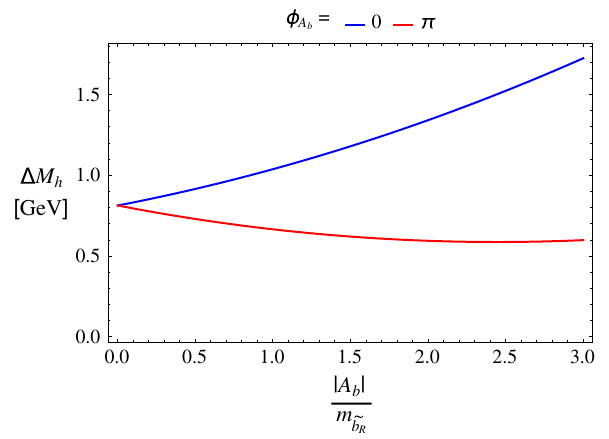
Fig. 6 Dependence of the lightest Higgs-mass shift (cid:7) M h on | A b | . The sign of A b is either positive (blue) or negative (red), and sgn[ μ ] = − 1